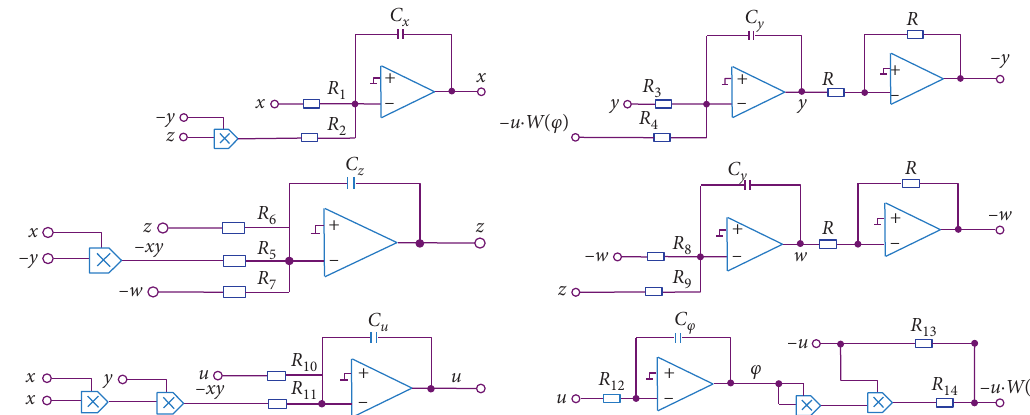
Figure 10: The circuit diagram of system (4).